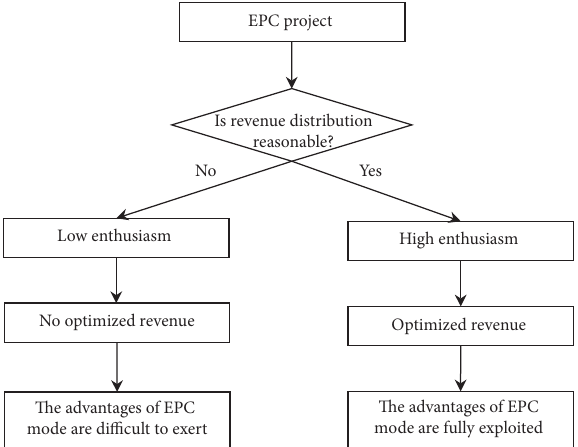
Figure 1: Profit sharing motivation model of the EPC project (self-